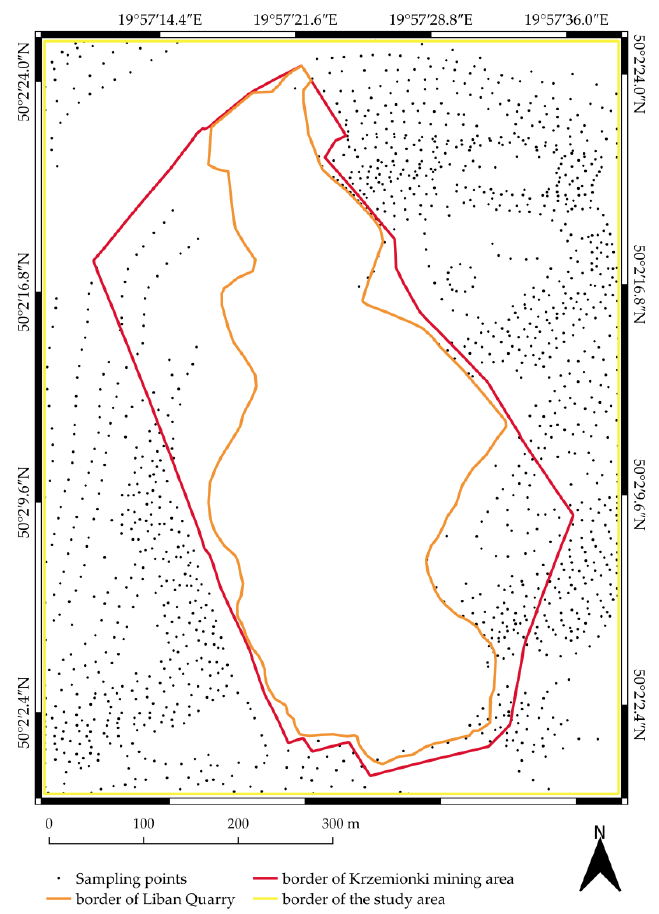
Figure 4. Distribution of points from the contour lines digitisation in the Krzemionki mining area and its surroundings.